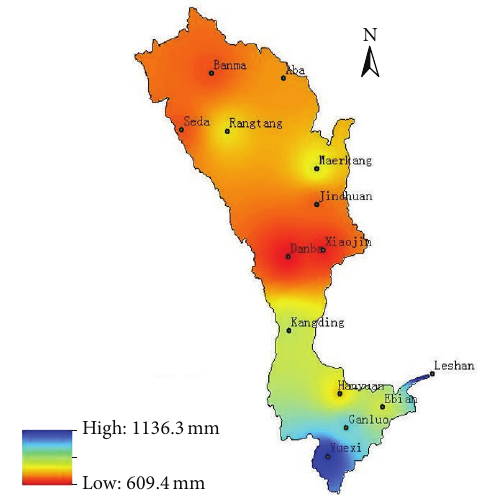
Figure 4: Spatial distribution of annual average precipitation in the study area.